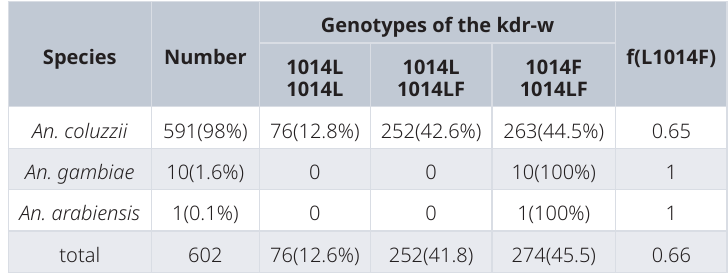
Table 6. Species identification and kdr genotyping by polymerase chain reaction